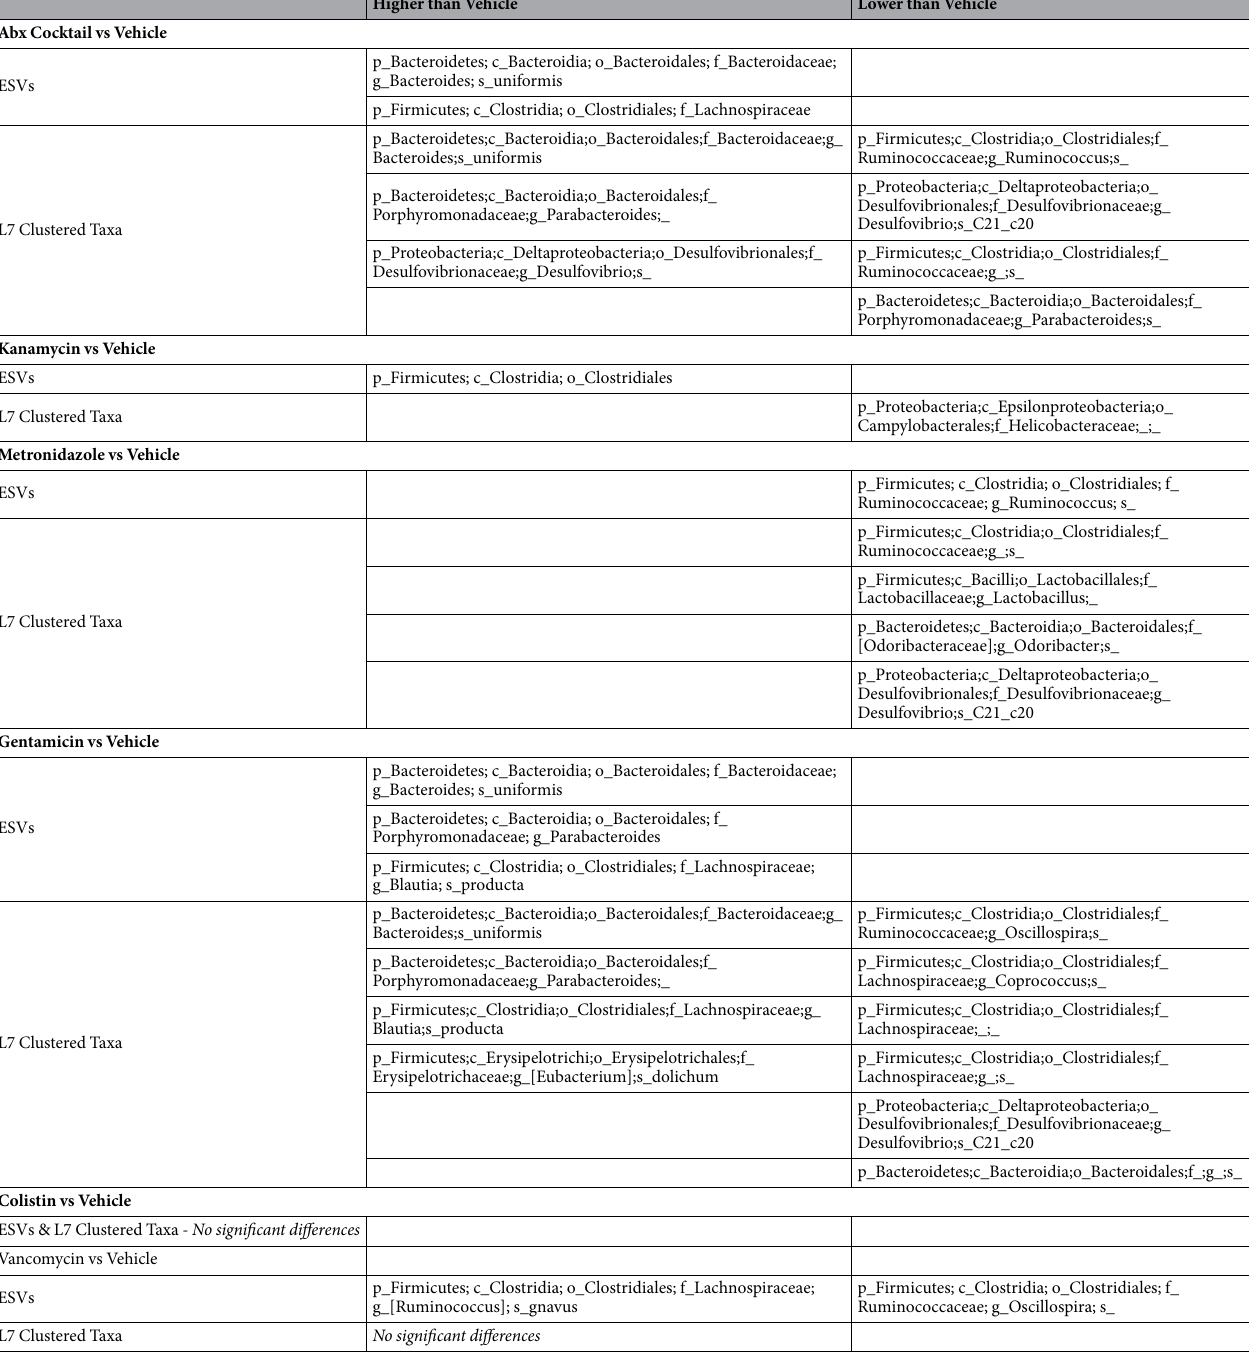
Table 1. QIIME 2 ANCOM analysis of microbial taxa in each ABX-treated group versus Vehicle-treated